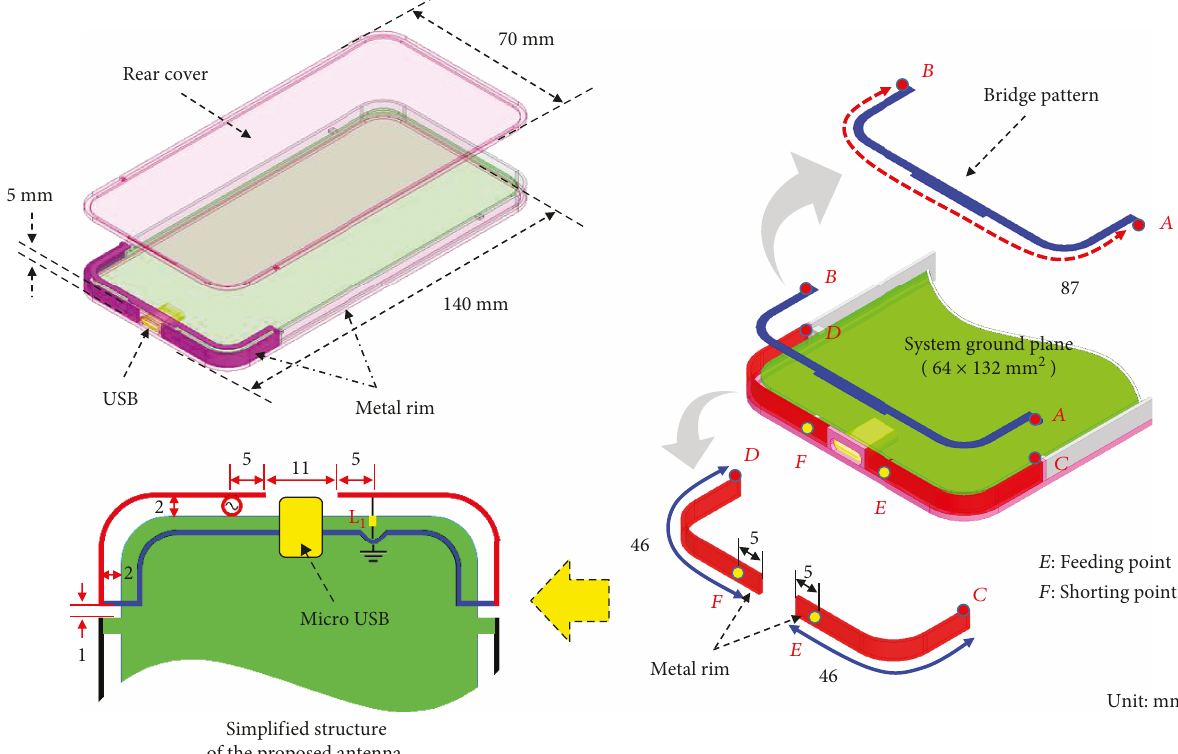
Figure 4: Geometry of the proposed antenna with a ground clearance of 2mm for LTE metal-rimmed smartphone.